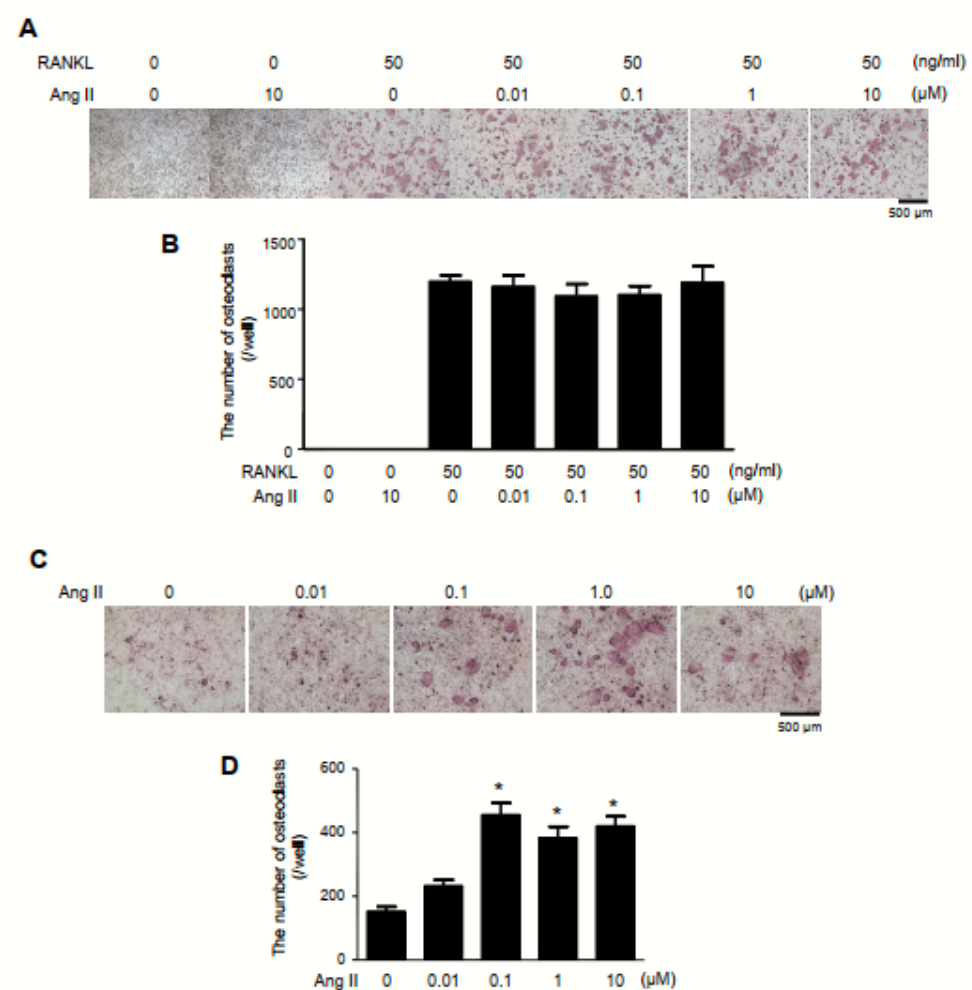
Figure A5. Effect of angiotensin (Ang II) on osteoclast differentiation. Primary mouse bone marrow cells were isolated from the long bones of 10-week-old wild-type mice. Non-adherent bone marrow cells were seeded on 48-well plates and incubated for 2 days with macrophage colony-stimulating factor (M-CSF; 25 ng/mL). After pre-culture for 2 days, yielded bone marrow-derived macrophages were stimulated with RANKL (50 ng/mL) and Ang II at the indicated concentrations for an additional 3 days in the presence of M-CSF. The formation of tartrate-resistant acid phosphatase (TRAP)-positive multinucleated cells (TRAP + MNCs) was visualized by TRAP staining. ( A ) Representative TRAP staining images. ( B ) The number of osteoclasts. TRAP + MNCs with three or more nuclei were counted as osteoclasts. Bone marrow-derived macrophages were co-cultured with neonatal calvarial osteoblasts in the presence of 10 nM 1 α , 25-dihydroxyvitamin D3, and 1 μ M prostaglandin E2. The cells were stimulated with Ang II (0.01–10 μ M) for 7 days. TRAP + MNCs were visualized by TRAP staining. ( C ) Representative TRAP staining images. ( D ) The number of osteoclasts. Values are the mean ± SEM. n.s., not significant. *, p < 0.05 vs. non-treated control. Detailed methods are described in the Supporting Information.